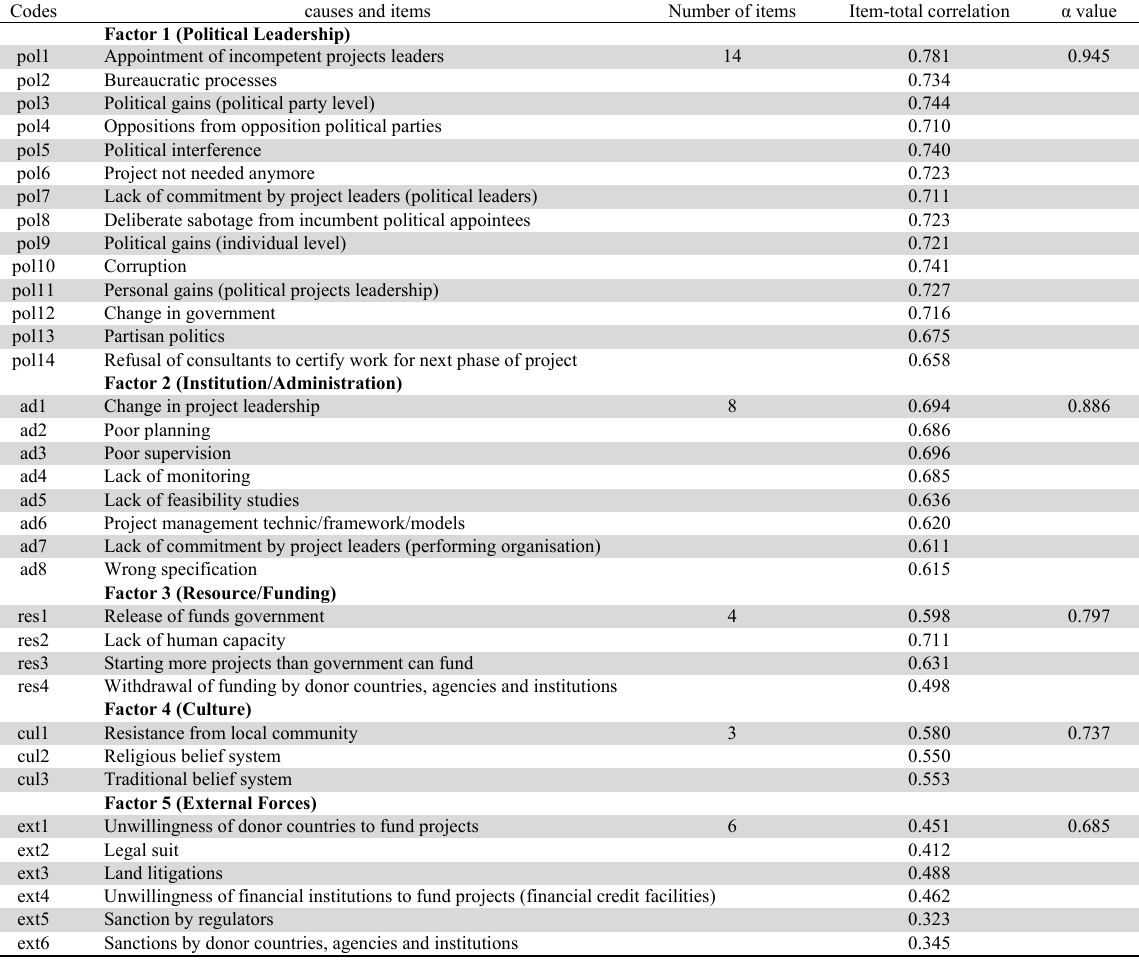
Internal consistency of final revised structure